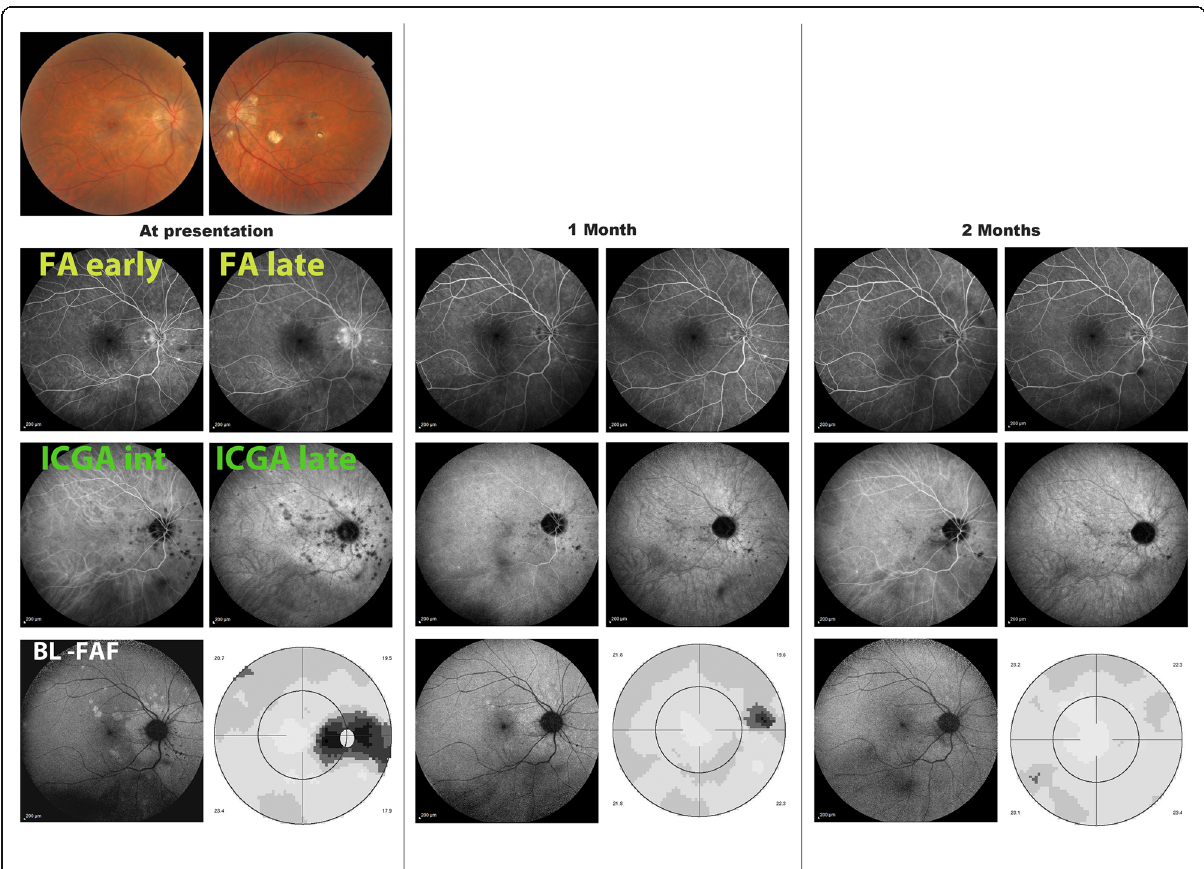
Fig. 10 Multifocal choroiditis (MFC) Multimodal imaging monitoring of evolution of lesions following corticosteroid/immunosuppressive treatment. At presentation FA only shows old punctiform cicatricial hyperfluorescent pinpoints nasal to disc. ICGA (late frame) shows the numerous new lesions corresponding to BL-FAF hyperautofluorescence. After 2 months of treatment, BL-FAF, ICGA and visual field have